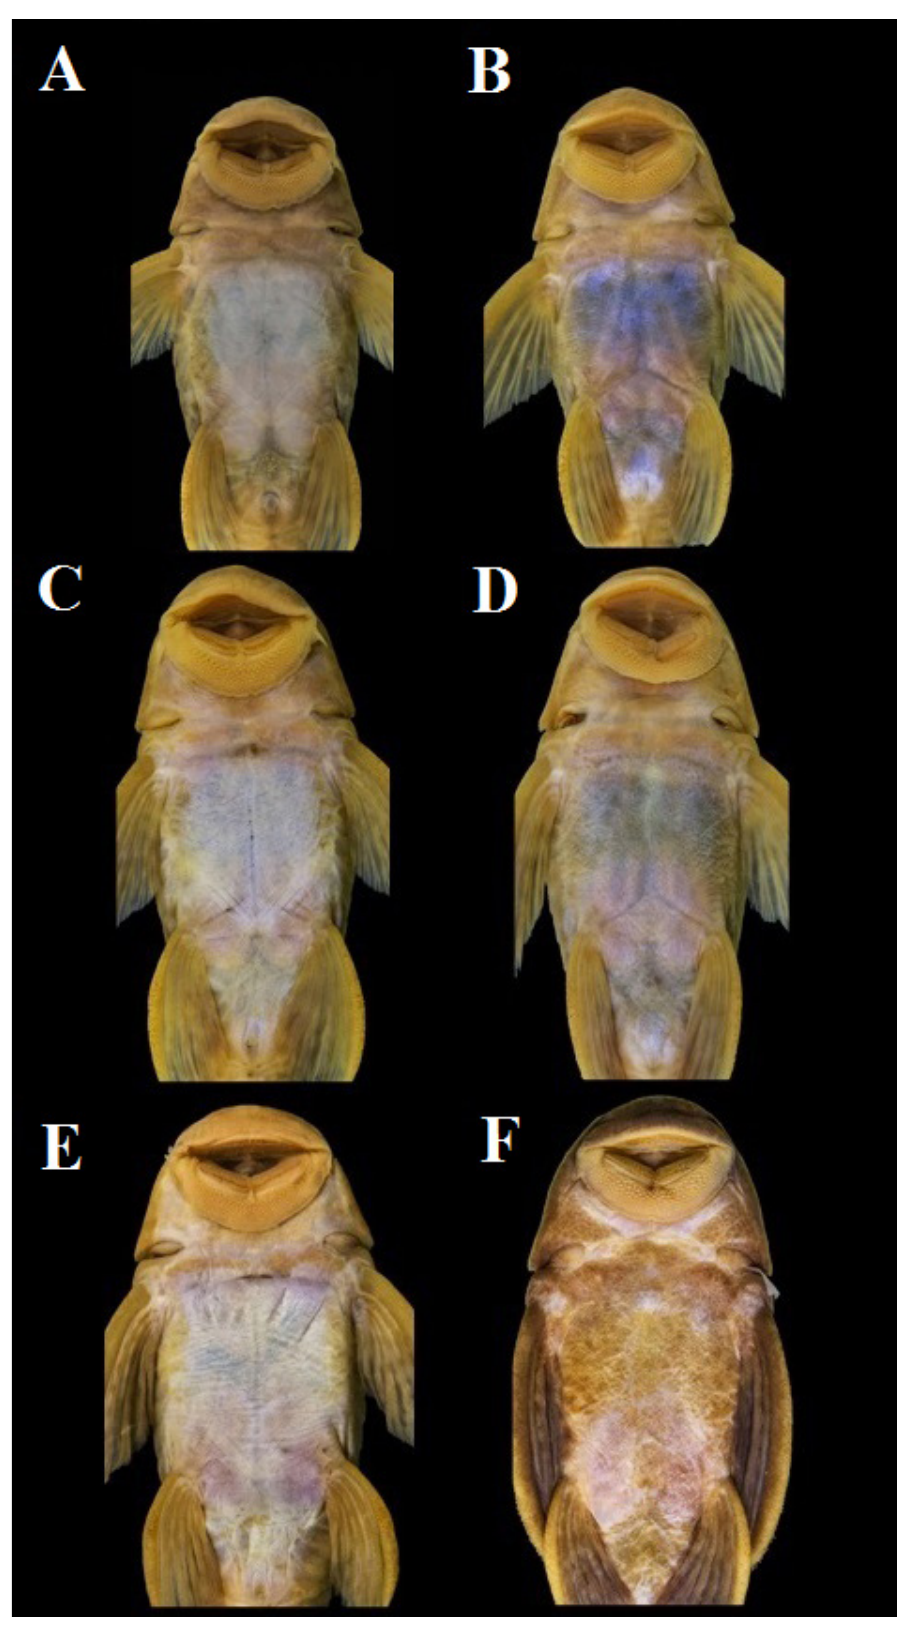
FIGURE 4 | Ontogenetic development of plates from the anteromedial region of Hypostomus johnii and